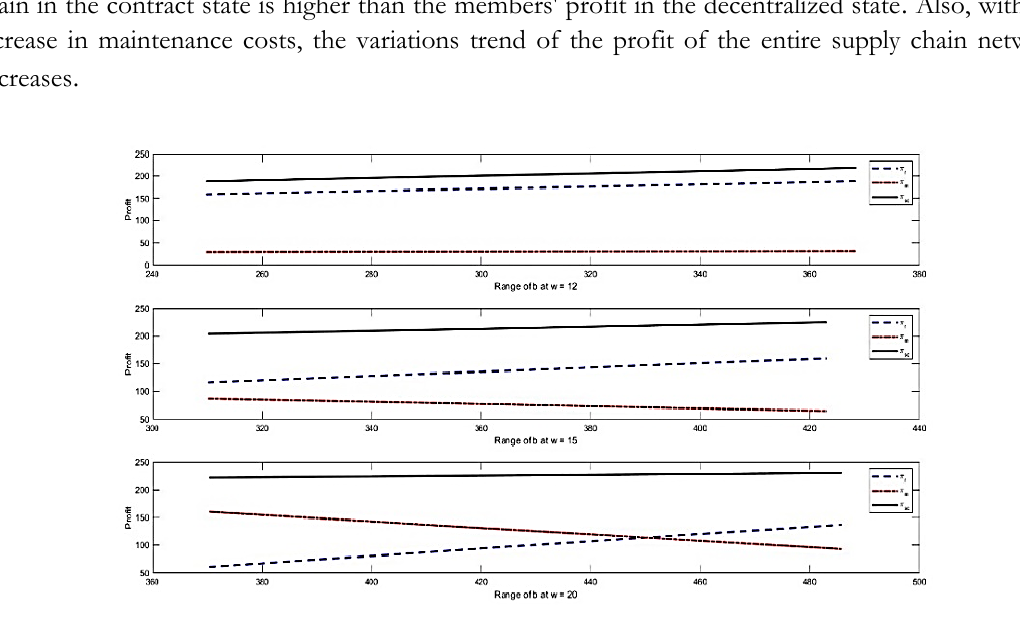
Fig. 9. The trend of variations in firms' profits due to variations in wholesale prices post-contract. In the following, the problem sensitivity is analyzed under the input parameter α . The profits of the chain members by variations in the value of α are shown in Table 12 , including the profits of the retailer, producer, and the whole chain . Table 12. The trend of variations in firms' profits due to variations in parameter 𝛂 post-contract.